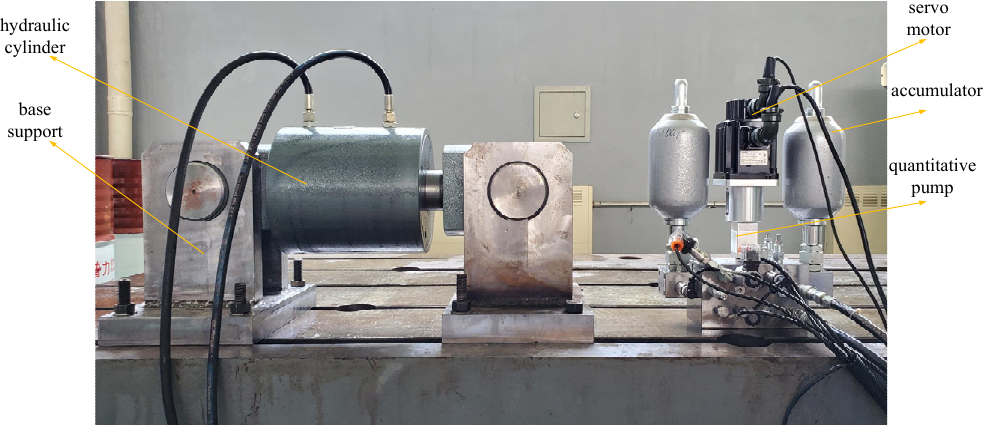
Figure 5. Hydraulic system test bench.